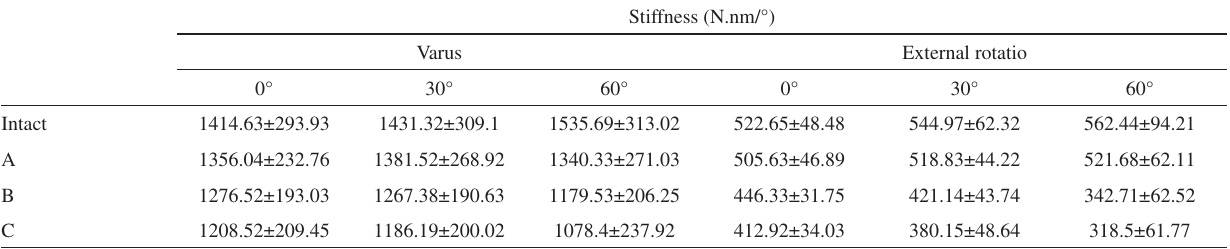
Table 2 - Stiffness during the application of a deforming force in varus and external rotation (mean ± standard deviation). Stiffness (N.nm/°)